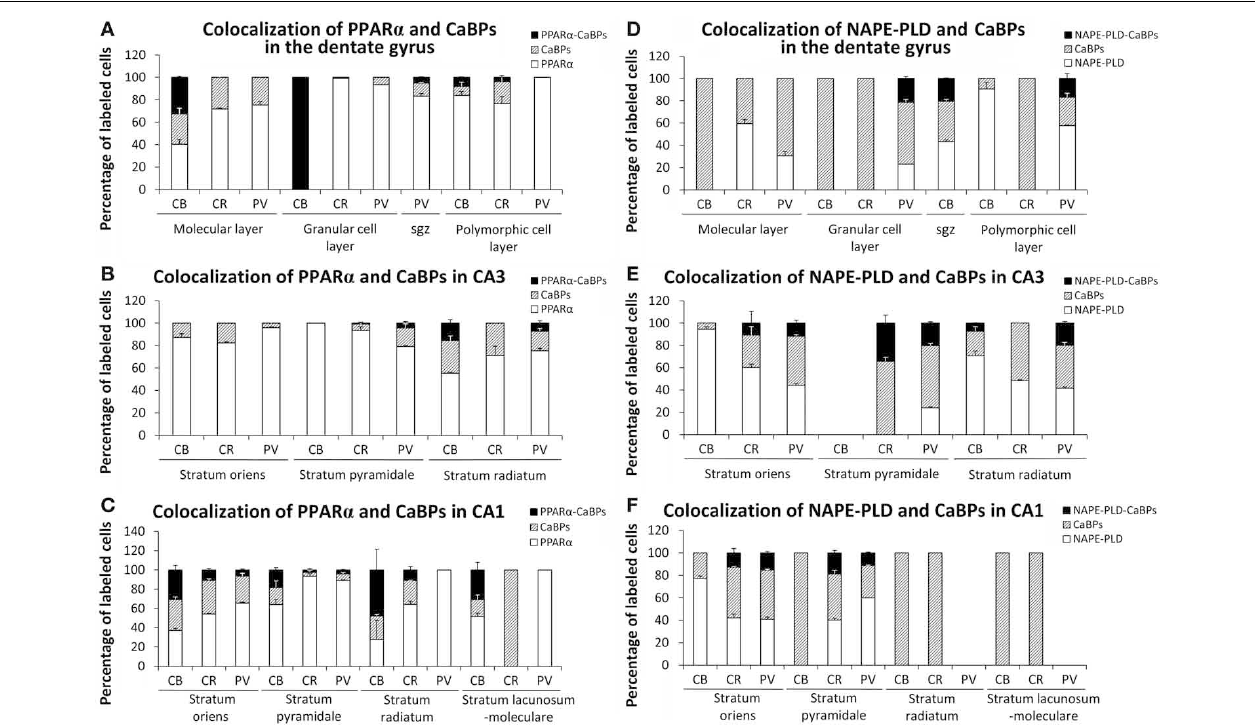
FIGURE 9 | Quantification of the proportion of cells labeled with PPAR α (A–C) or NAPE-PLD (D–F) that express calbindin, calretinin, or parvalbumin in each layer of the dentate gyrus, CA3, and CA1. Bars represent the percentage of labeled cells in each